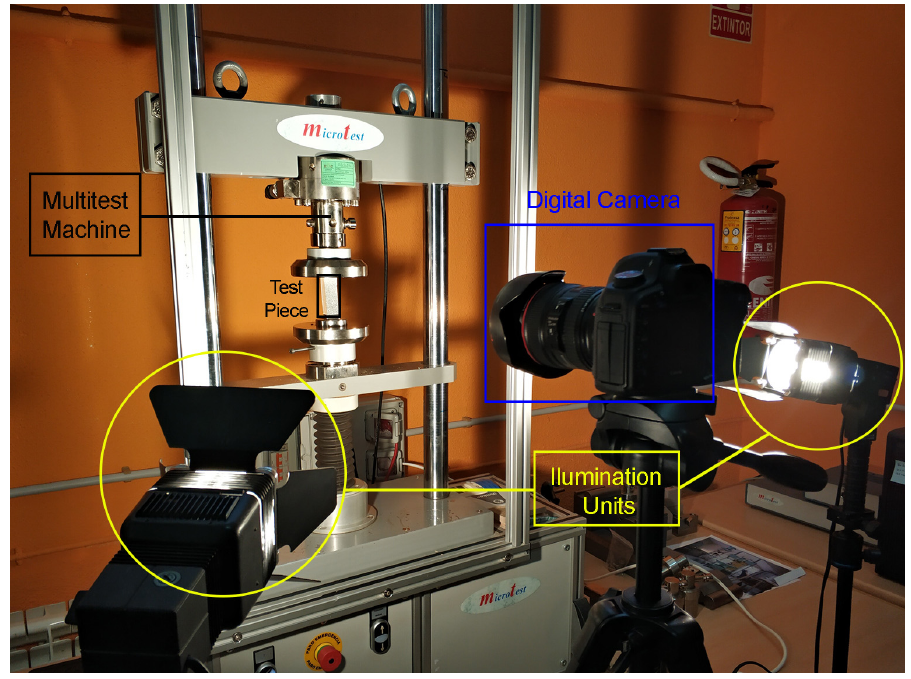
Figure 3. Complete test